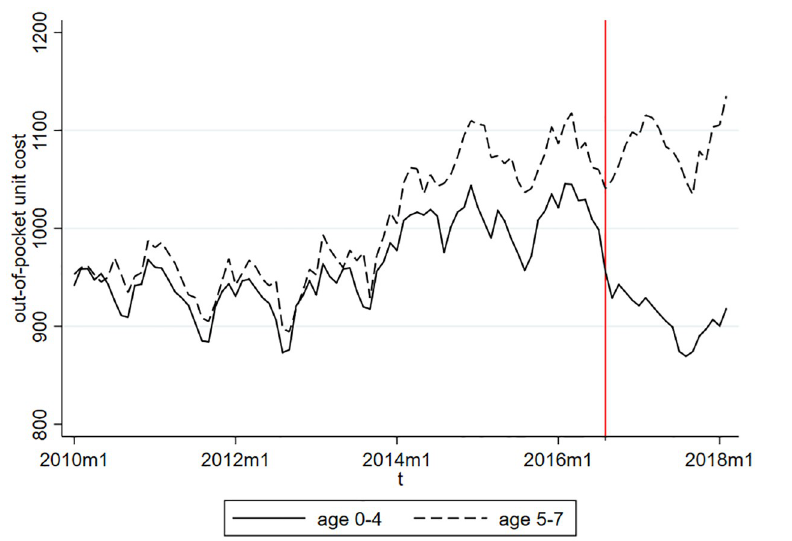
Fig 2. Average out-of-pocket unit cost (in HUF) of antibiotics by age groups.